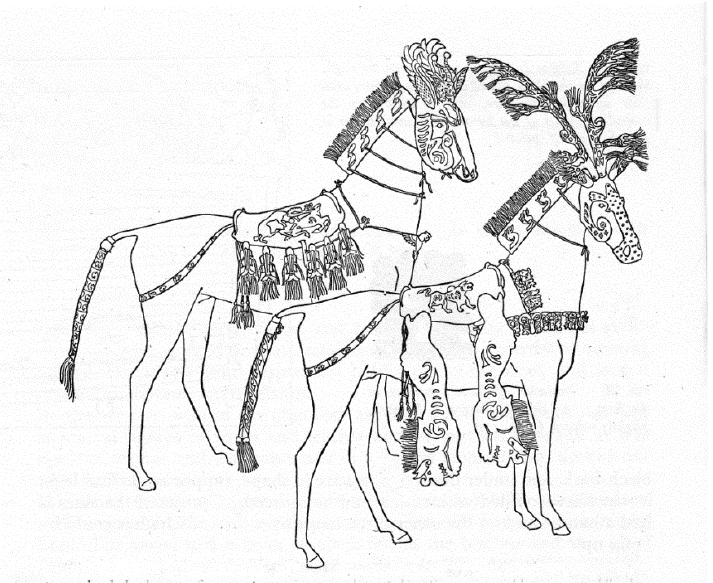
Figure 8. Reconstruction drawing of two lavishly decorated horses with felt saddle covers and masks and headgear of felt, leather, fur, dyed horsehair, and gold foil. Left is topped with a horned lion–griffon and right with stag antlers. Pazyryk, kurgan 1. Adapted from Jettmar 1967: Figure 87.